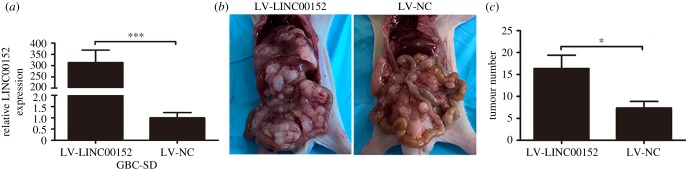
Effect of LINC00152 on peritoneal spreading and metastasis in vivo. (a) The expression of LINC00152 in GBC-SD cells transfected with LV-LINC00152 and LV-NC were quantified by qPCR. (b,c) The number of the peritoneal spreading and metastasis nodules derived from GBC-SD/LV-LINC00152 and GBC-SD/LV-NC in nude mice was evaluated. The mean ± s.d. of triplicate experiments were plotted. *p < 0.05, ***p < 0.001.